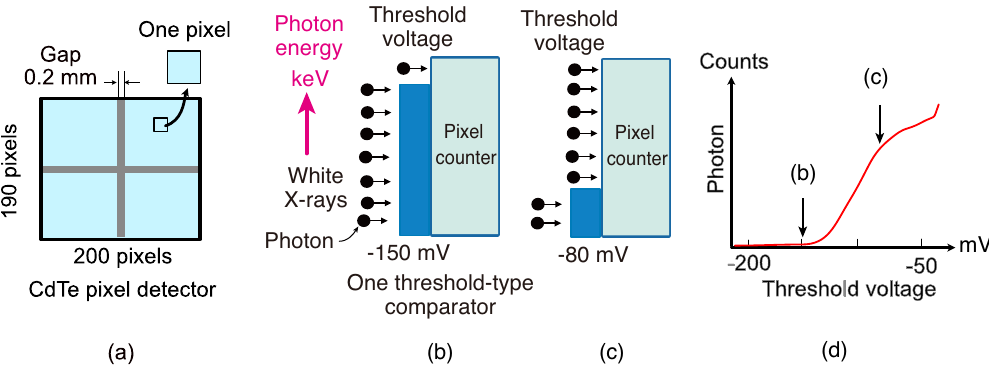
Figure 4. Mechanism of energy-resolved photon counting by the CdTe pixel detector. ( a ) CdTe pixel detector. Each pixel functions as an energy-resolved counter; ( b ) white X-rays include a wide energy range of wavelengths; ( c ) the energy of the counted photon is limited by the threshold voltage of one threshold-type comparator; ( d ) relationship between threshold voltage and counts of